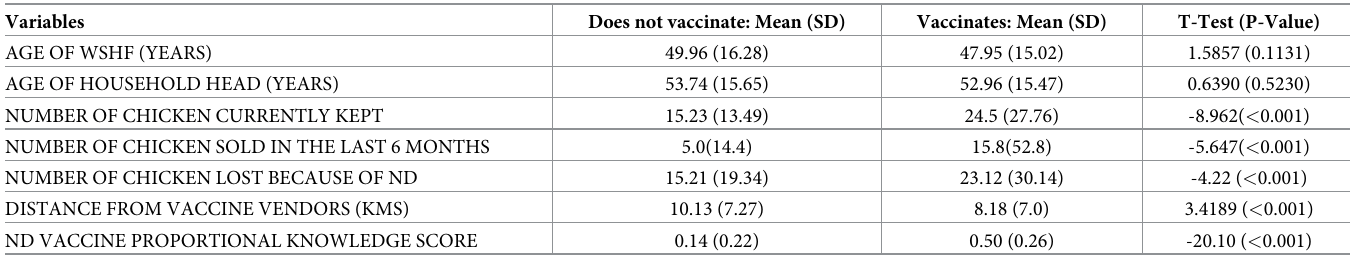
Table 1. Continuous variables associated with vaccination of chicken.